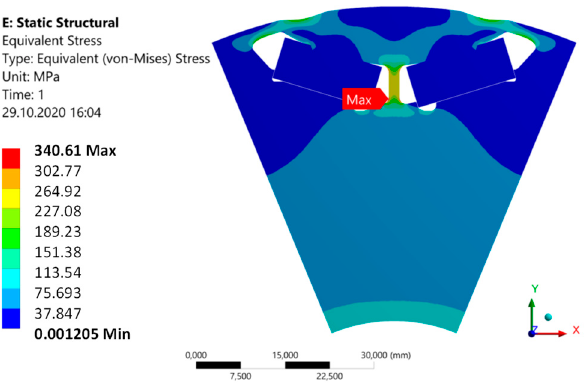
Figure 1. Distribution of von Mises stresses of Toyota Prius III rotor at 13,500 rpm.